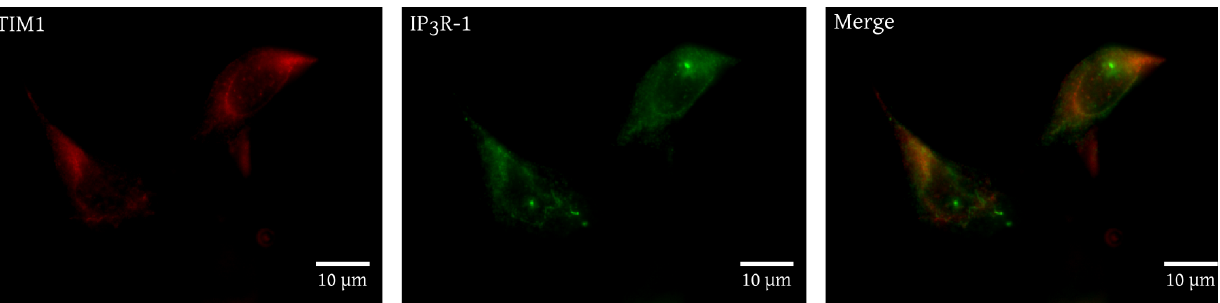
Fig. 2. STIM1 and IP 3 R-1 are widely distributed throughout the endoplasmic reticulum in BAECs. A) BAECs were grown on cover glasses, fixed with methanol and incubated with mouse anti-STIM1 and rabbit anti-IP 3 R-1 antibodies. Fluorescent staining was obtained with AlexaFluor 594-conjugated (STIM1, left panel) and AlexaFluor 488-conjugated (IP 3 R-1, center panel) secondary antibodies. The right panel represents the overlay of these images. The results are representative of three independent experiments performed on different cells